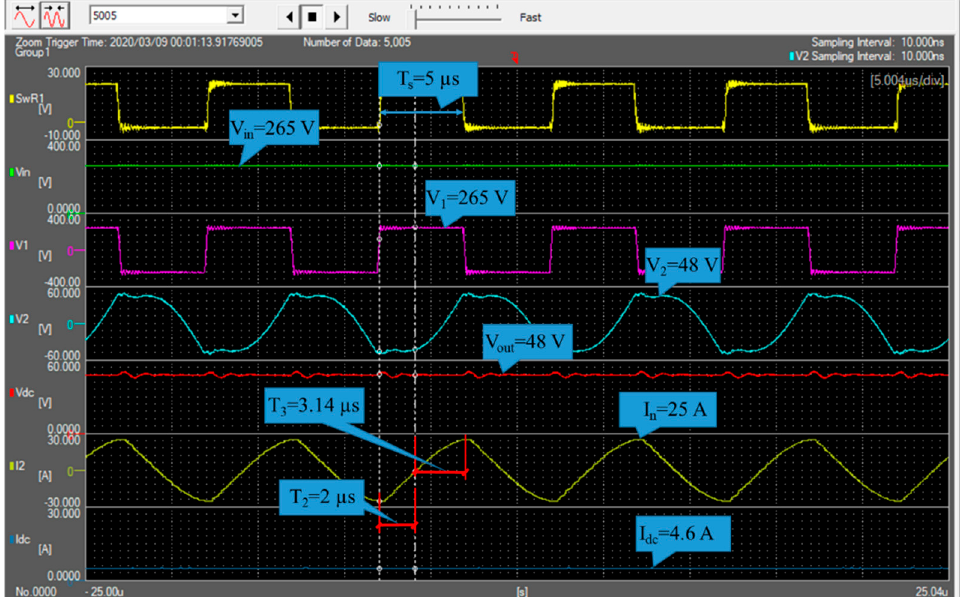
Figure 11. Experimental voltage and current waveforms at (cid:1858) (cid:3046) = 100 kHz .